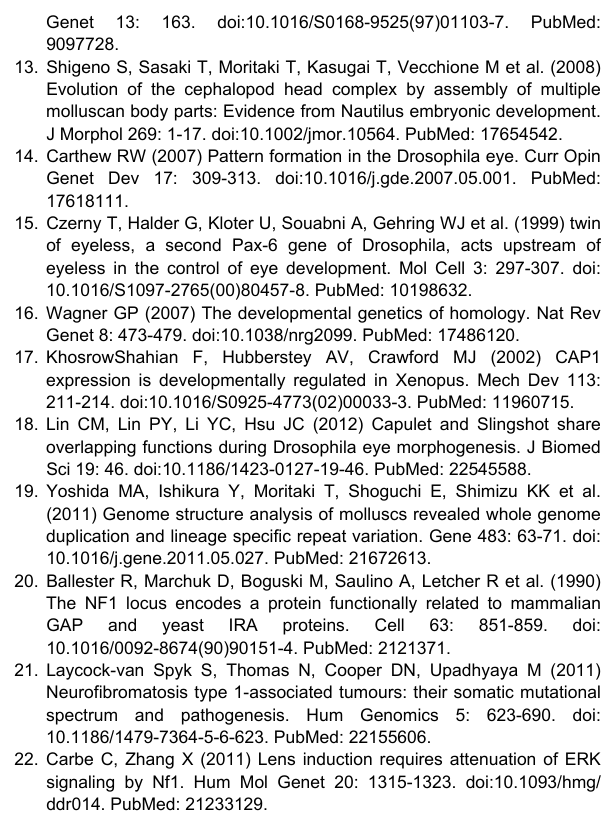
Table S1. GO enrichment analysis of contigs up-regulated at least two-fold in Nautilus and squid samples. (XLSX) Table S2. Nautilus and squid eye-related genes as found by comparisons with Human and Drosophila homologues. (XLSX) Table S3. Potential candidate gene pairs for lens evolution in squid. (XLSX) Text S1. Alignment of NF1/Nf1 Nautilus contigs that have best hits with the Human and Drosophila NF1/Nf1 protein. (TXT) Figure S1. Alignment of squid and Nautilus contigs that have best hits with Human and Drosophila CAP1/capt homologues respectively. Asterisk(*) indicates sequence identity.